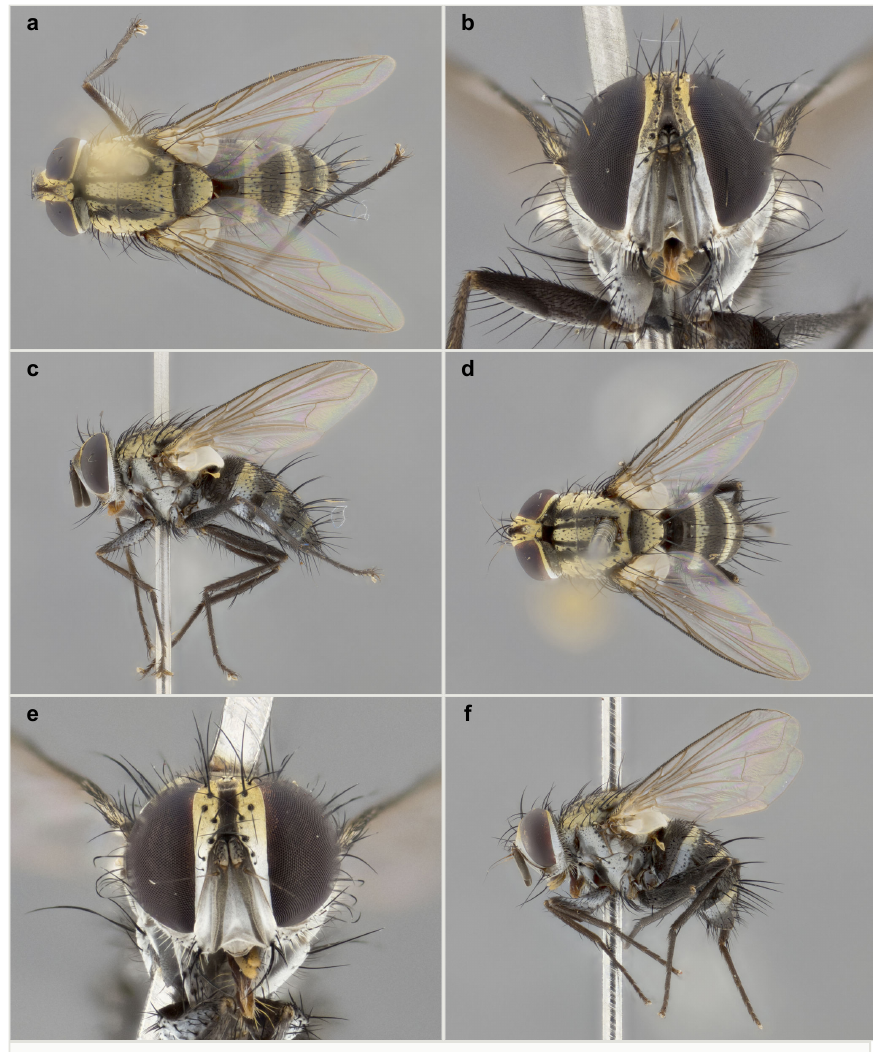
General morphology of Calolydella timjamesi sp. n. ; a–c : male holotype, voucher